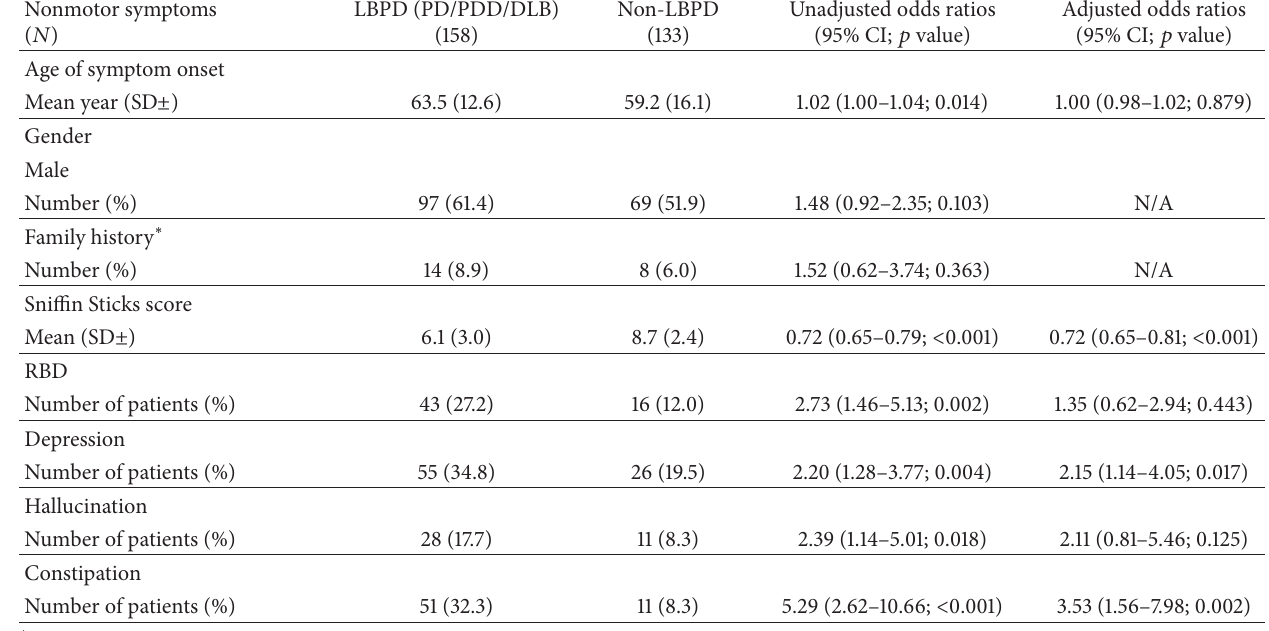
Table 3: Unadjusted and adjusted odds ratios in association with LBPD